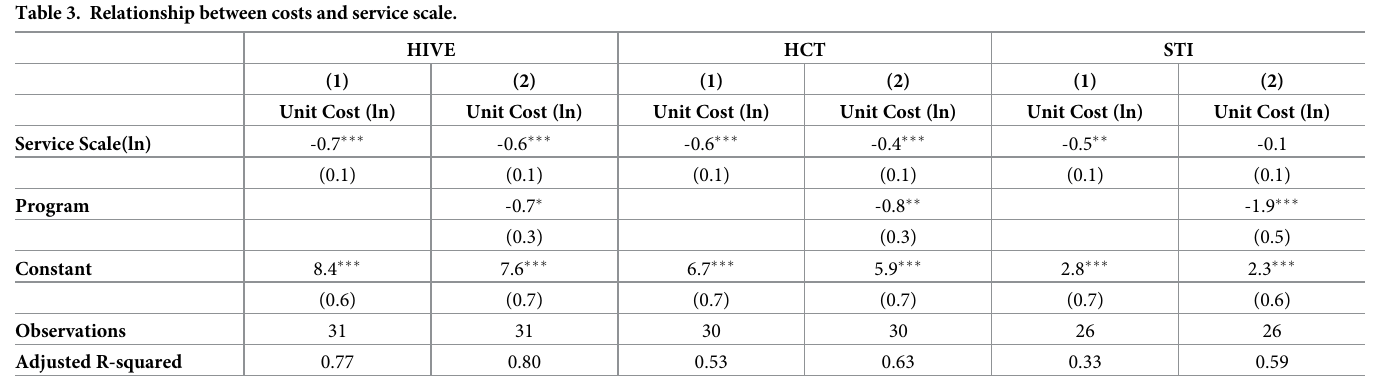
Table 3. Relationship between costs and service